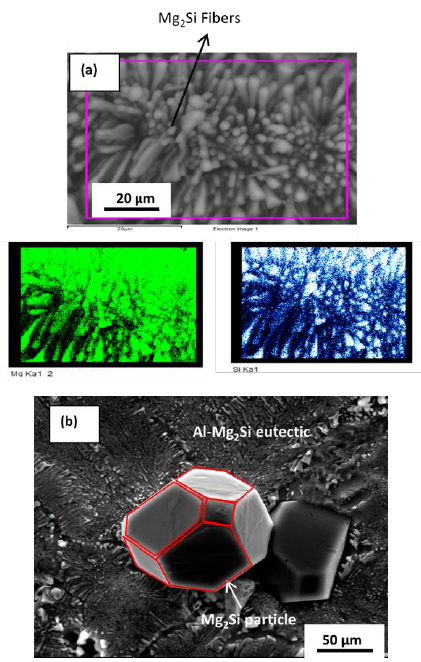
Figure 9. ( a ) SEM BS image taken from a deep-etched sample and the corresponding EDS elemental maps from the selected region and ( b ) a deep-etched sample showing a primary polygonal-shaped Mg 2 Si particle for the Al-13.1 wt.% Mg 2 Si-300 ppm P alloy. White arrows indicate squares and a hexagons structure, which is identical to the geometrically shaped tetrakaidecahedron.